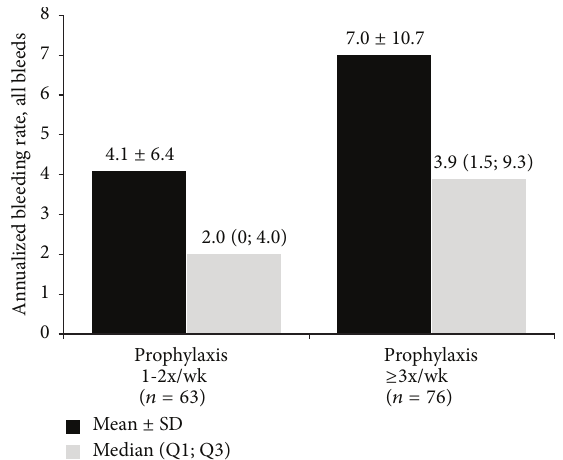
Figure 1: Annualized bleeding rate for all bleeds by dosing group. Q1 = quartile 1; Q3 = quartile